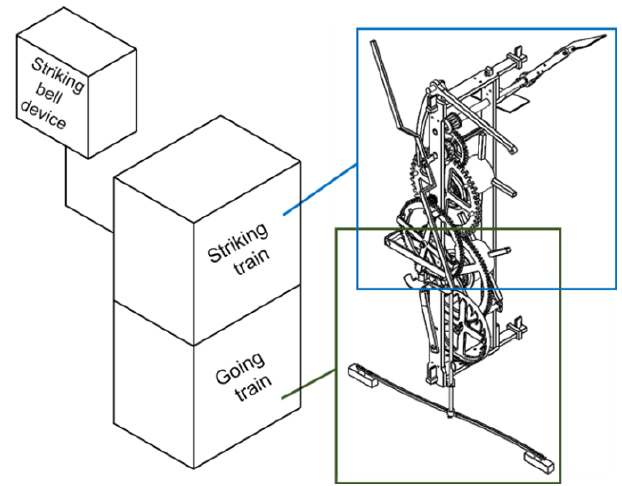
Figure 1. Structure of the Cotehele clock